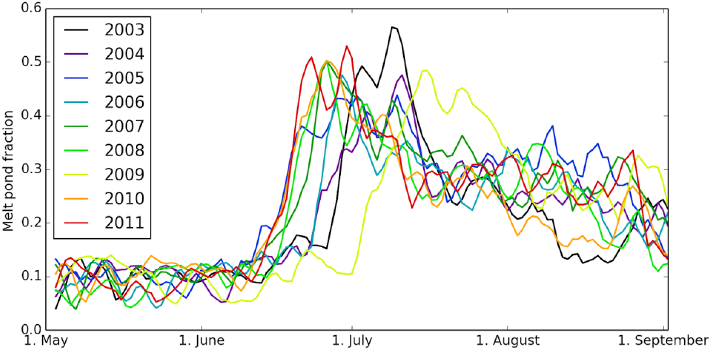
Figure 10. Time sequence of MPF for the studied years for the area of positive MPF trend in the Queen Elizabeth Islands (78 ◦ N, 108 ◦ E, marked with the red square “QE” in Fig. 1). In the 3rd–4th week of June the MPF in the earlier years of the MERIS data set reached peak values later in the summer as compared to later years, and melt onset in the later year happens earlier than before. Running mean with window size 3 has been applied to the